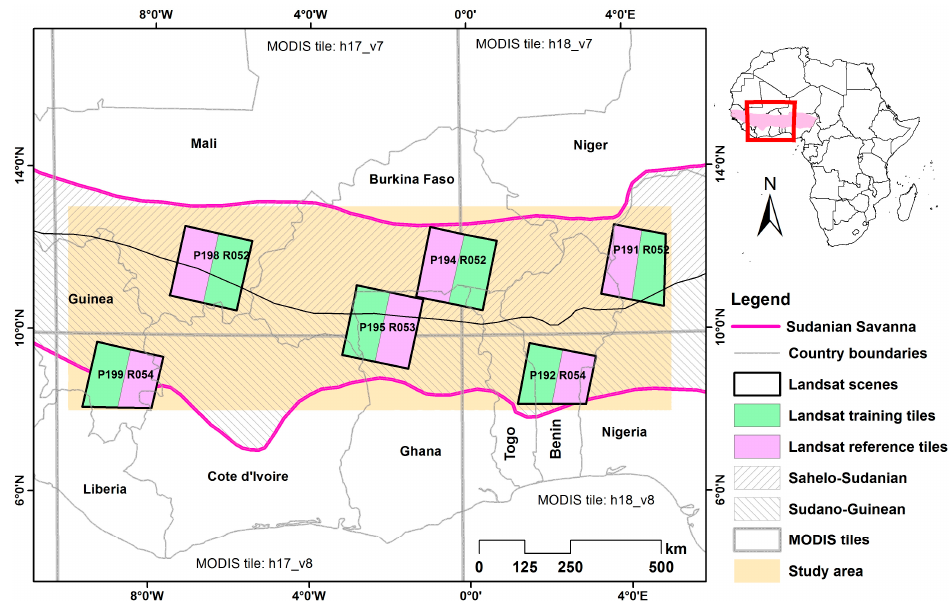
Figure 1. Map of the study area showing the extent of the Sudanian Savanna and the Landsat scenes analyzed. Shapes of Landsat scenes at the borders of the study area have been resized to align to the border.